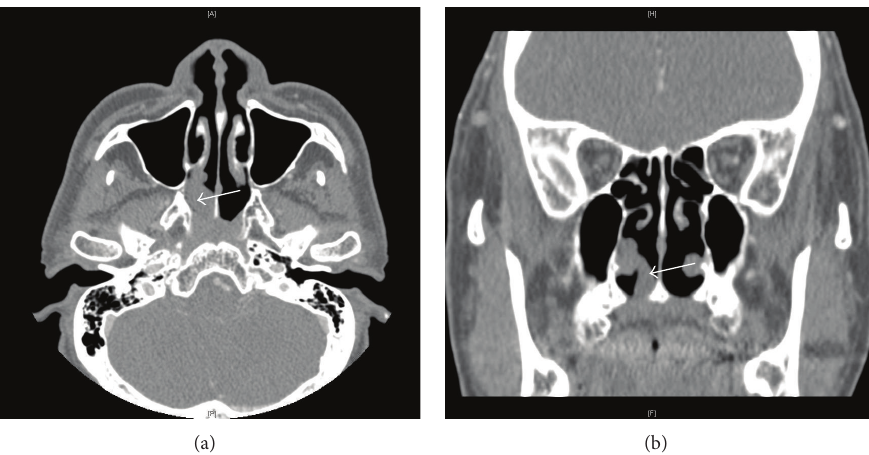
Figure 1: Preoperative paranasal sinus CT. Nasal polyp originating from the posterior portion of the right inferior turbinate is protruding into the choana ((a) axial view, (b) coronal view).